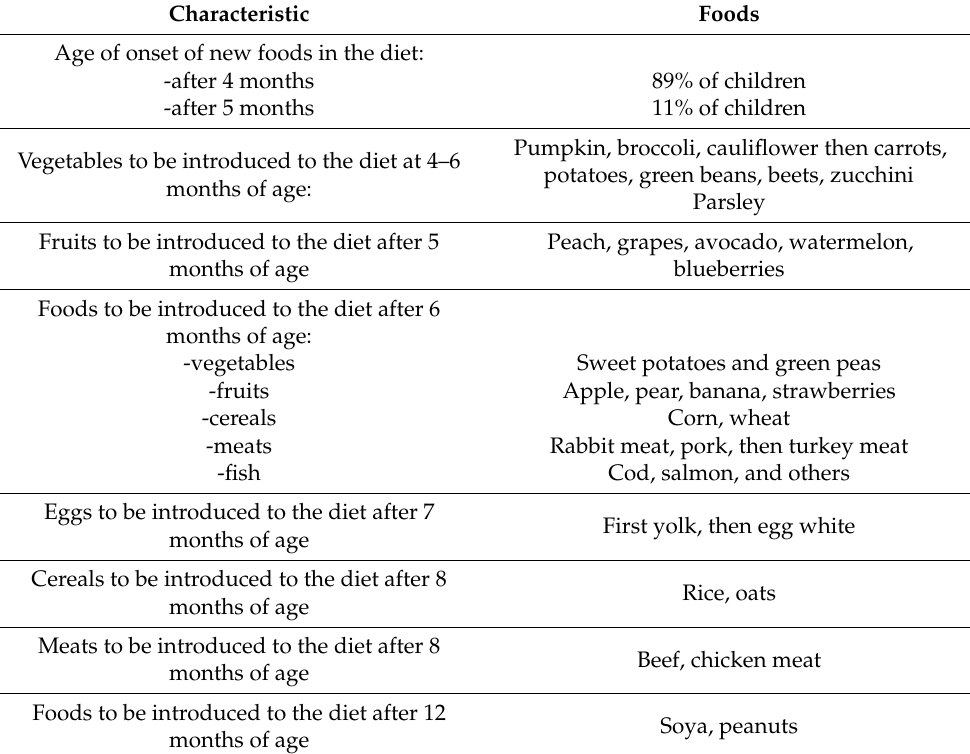
Table 4. Introducing new foods to the diet in the study group of children with chronic food protein- induced enterocolitis syndrome (FPIES) dependent on cow’s milk protein intake. Characteristic Foods Age of onset of new foods in the diet: -after 4 months 89% of children -after 5